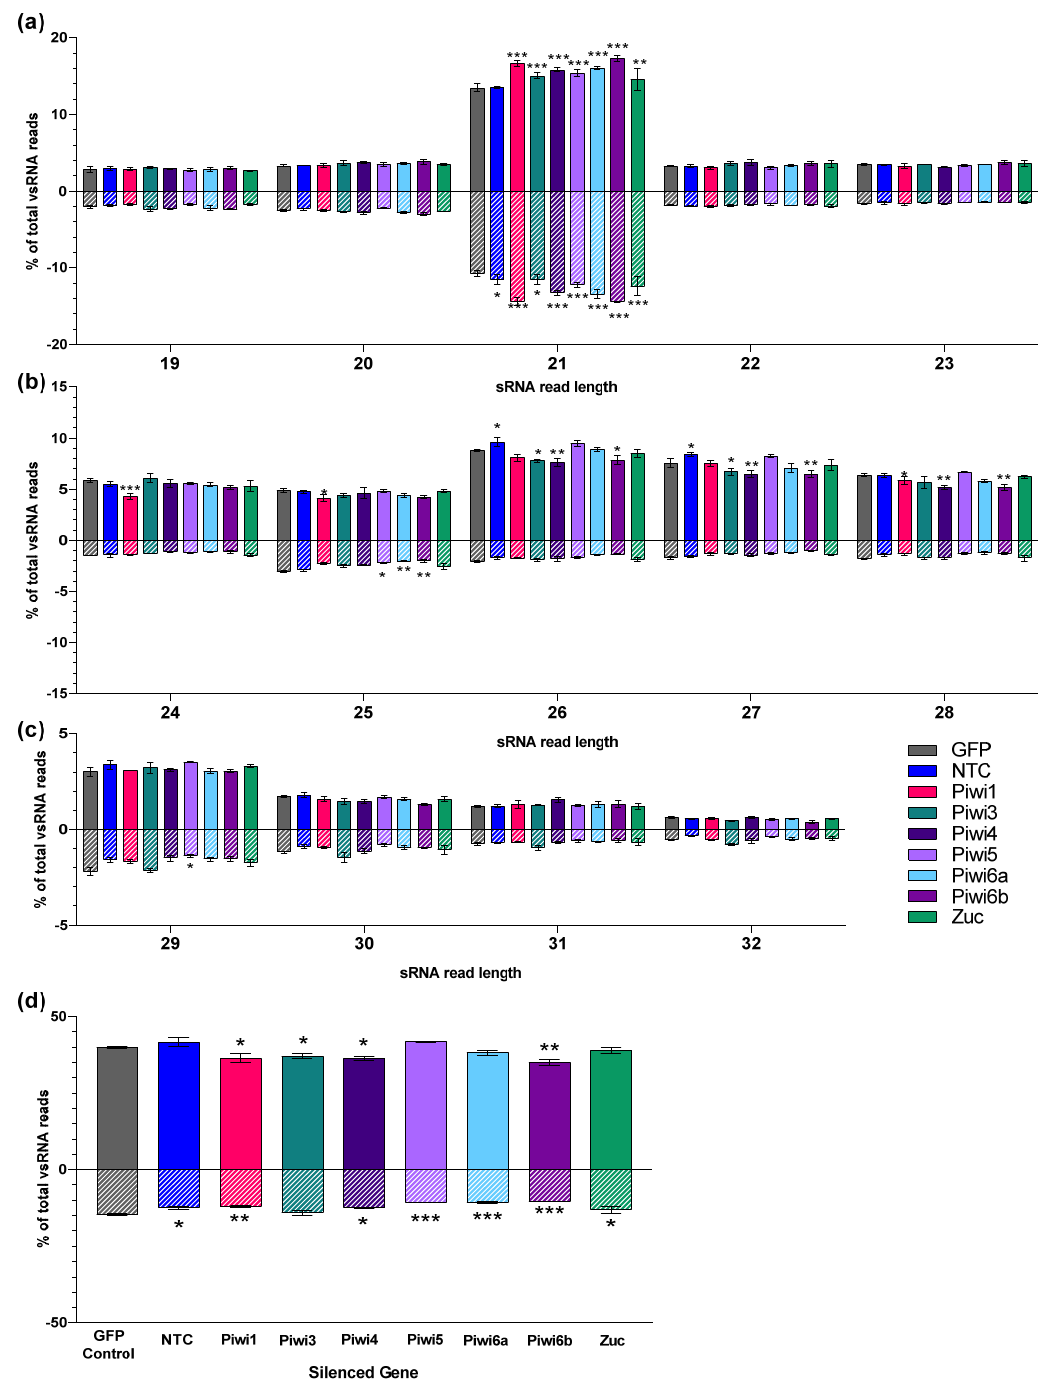
Figure 7. MERDV ‐ derived small RNAs in Cx. quinquefasciatus cells. MERDV ‐ derived sRNA reads from 19 to 32 nt length were analyzed and are plotted separately for better visualization as 19–23 nt ( a ), 24–28 nt ( b ), 29–32 nt ( c ), and the sum of all 24–32 nt reads ( d ). Reads from individual size classes were normalized to total MERDV ‐ derived sRNA reads and are shown as % of total MERDV ‐ derived reads for each size class (full bars indicate positive ‐ sense reads, while hatched bars indicate negative ‐ sense reads). GFP dsRNA ‐ treated Hsu cells, and nontreated cells (NTC) were included as negative controls. Bars represent 3 biological replicates. Significant changes in reads were compared to the GFP control using Two ‐ Way ANOVA ( a – c ) or One ‐ Way ANOVA ( d ). Significance is indicated as * p < 0.05, ** p < 0.01, *** p < 0.001.